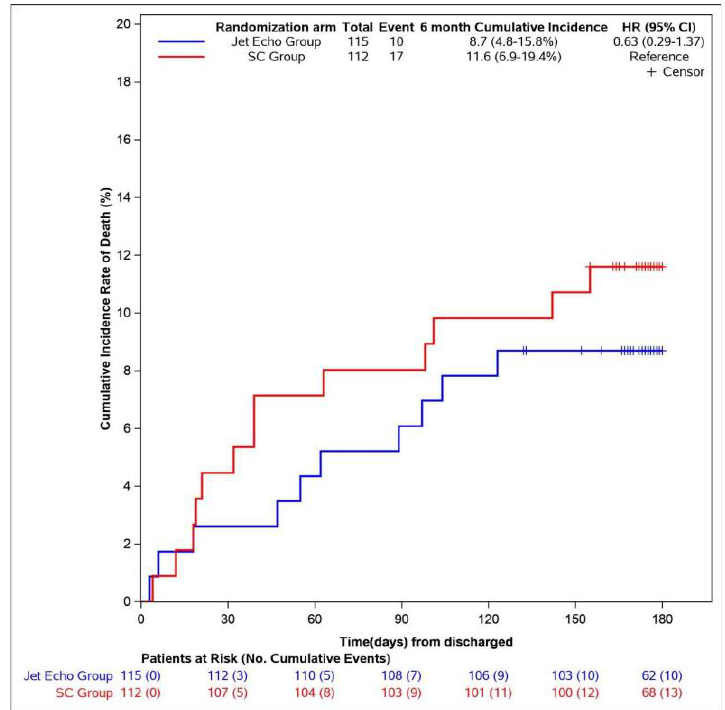
Figure 3. Cumulative Incidence of death from any causes at 6 months from discharge. HR = Hazard ratio. CI = Confidence interval.